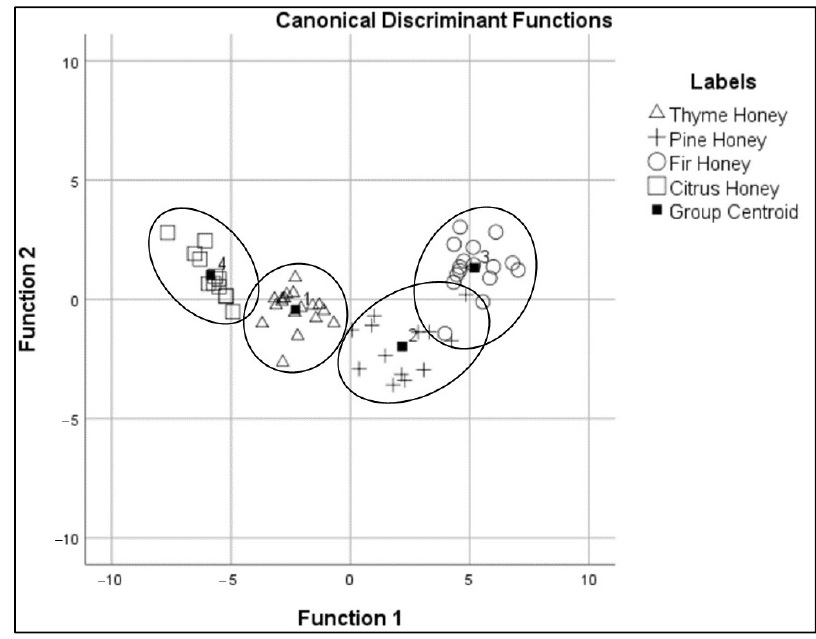
Figure 8. Discrimination results based on λ ex = 330 nm.